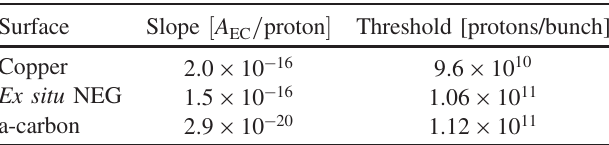
TABLE IV. Slopes of the pressure increase as a function of the bunch population. The value for a-C coating will be discuss in the results.